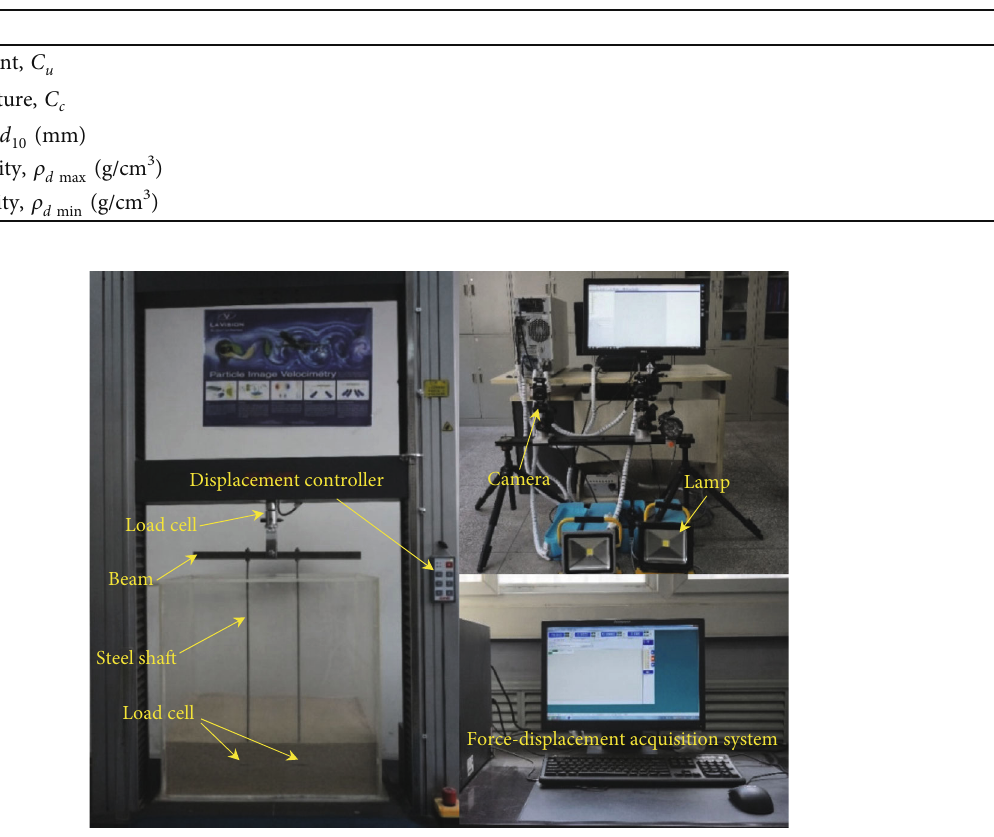
Table 1: Physical properties of sand.